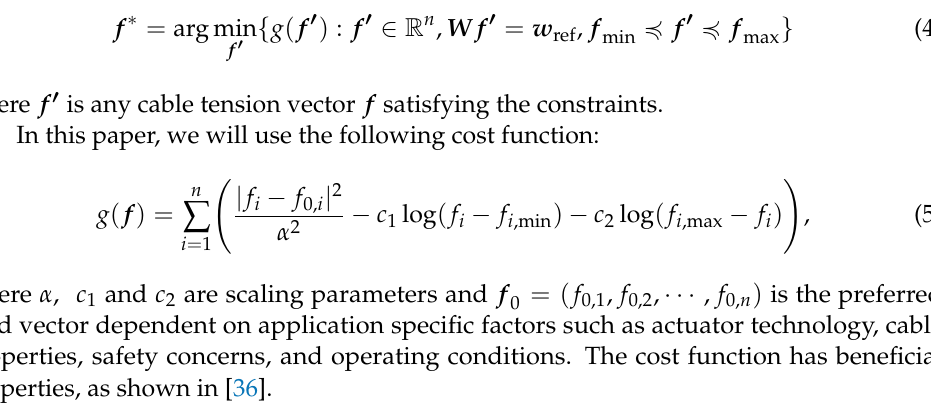
Figure 5. Reference frames and the experimental test setup with the platform (down-scaled physical substructure) connected to n actuated cables. One of the actuators is sketched and annotated. The set of cable attachment points { p body-fixed lever arms { r b } : = ( r b of the CDPR. The platform configuration of the CDPR refers to the actuator configuration combined with the platform pose η , and thus describes the cable endpoints for all actua- tor